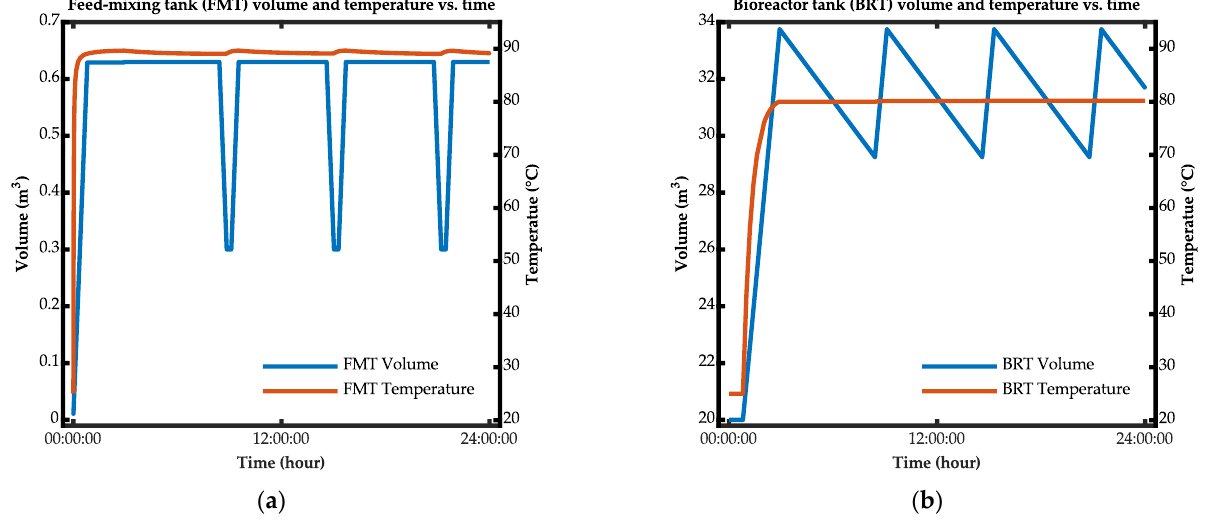
Figure 16. Simulation results for temperature and volume versus time of the ( a ) feed-mixing tank and ( b ) bioreactor tank.